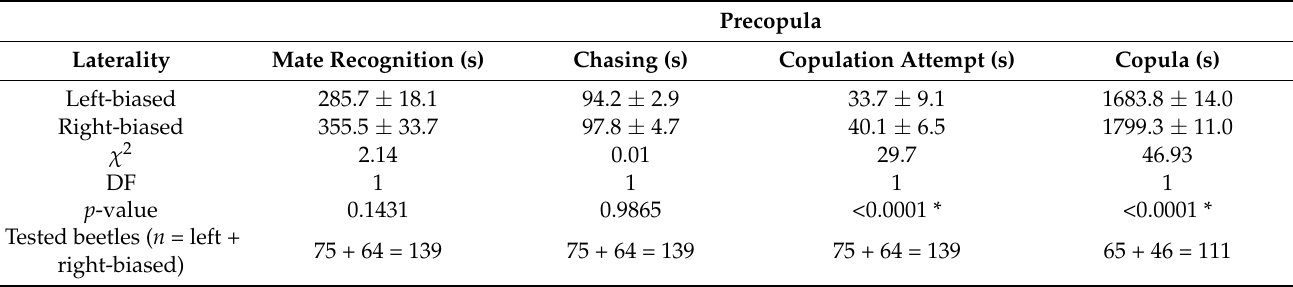
Table 2. Duration of Cryptolestes ferrugineus main mating behavior displays during sexual interactions characterized by a lateral turn of 180 ◦ . Values are means followed by standard errors (SE). Within each column, asterisks indicate significant differences (Steel–Dwass test, p < 0.05). Where no asterisks exist, no significant differences were